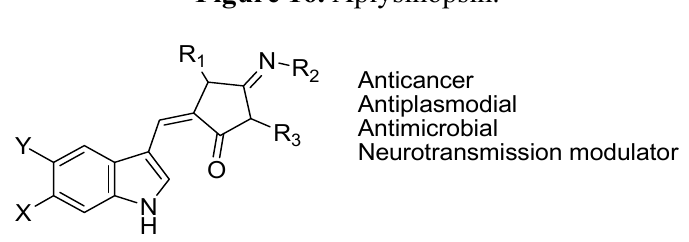
Figure 16. Aplysinopsin. Anticancer Antiplasmodial Antimicrobial Neurotransmission